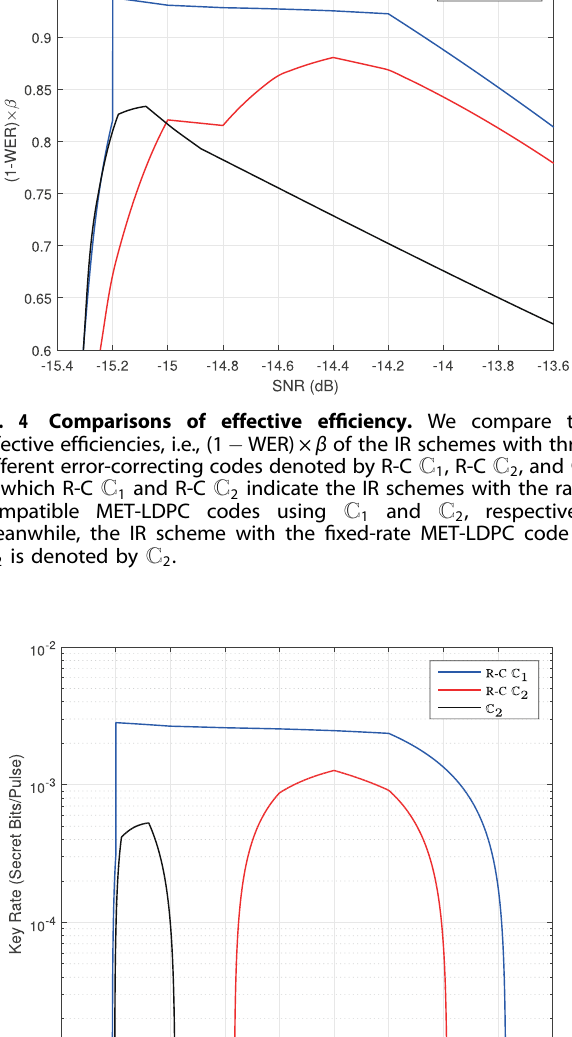
Fig. 6 Comparisons of key rates. a The key rate is evaluated in terms of bits per pulse for the three IR schemes denoted by R-C C 1 , R-C C 2 , and C 2 when the length of fi ber is assumed to be ℓ = 80 Km. b The key rate is evaluated when the length of fi ber is assumed to be ℓ = 85 Km.